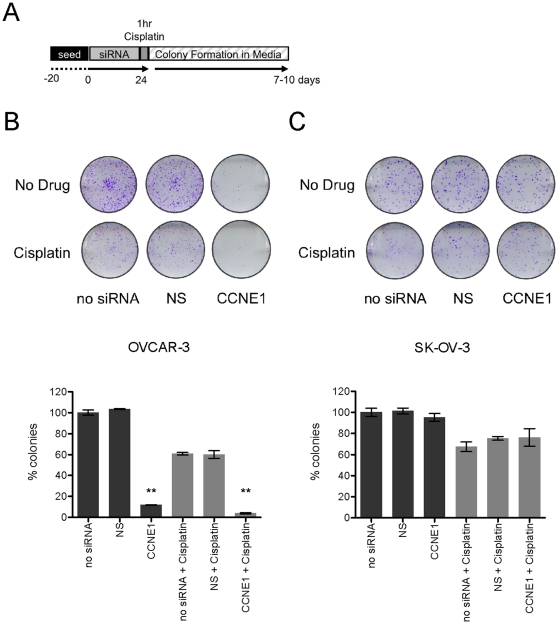
Clonogenic survival after CCNE1 knockdown and cisplatin treatment.(A) Experimental time-course for clonogenic survival assay after siRNA transfection and cisplatin treatment. Representative crystal violet stained (B) SK-OV-3 and (C) OVCAR-3 colonies (top) and average proportion of discrete colonies formed (bottom) compared to control cells without siRNA or 1 hour cisplatin treatment (3 µM or 6 µM for OVCAR-3 and SK-OV-3 cells respectively). Error bars indicate SEM (n = 3), **p-value <0.001.